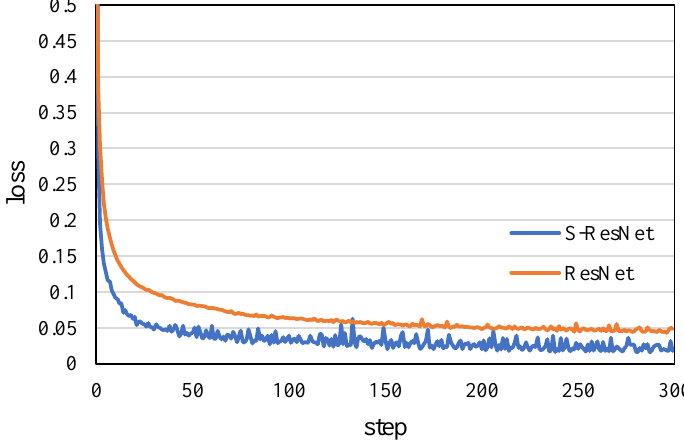
Figure 14. The change of the accuracy of the two IDSs when testing models.